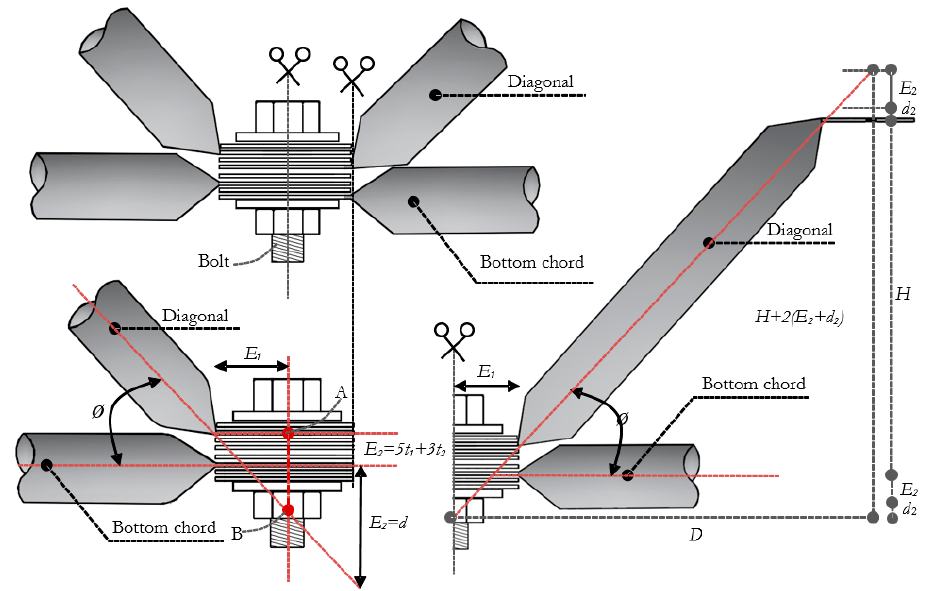
Figure 8. Trigonometric relations for typical connection in space truss.